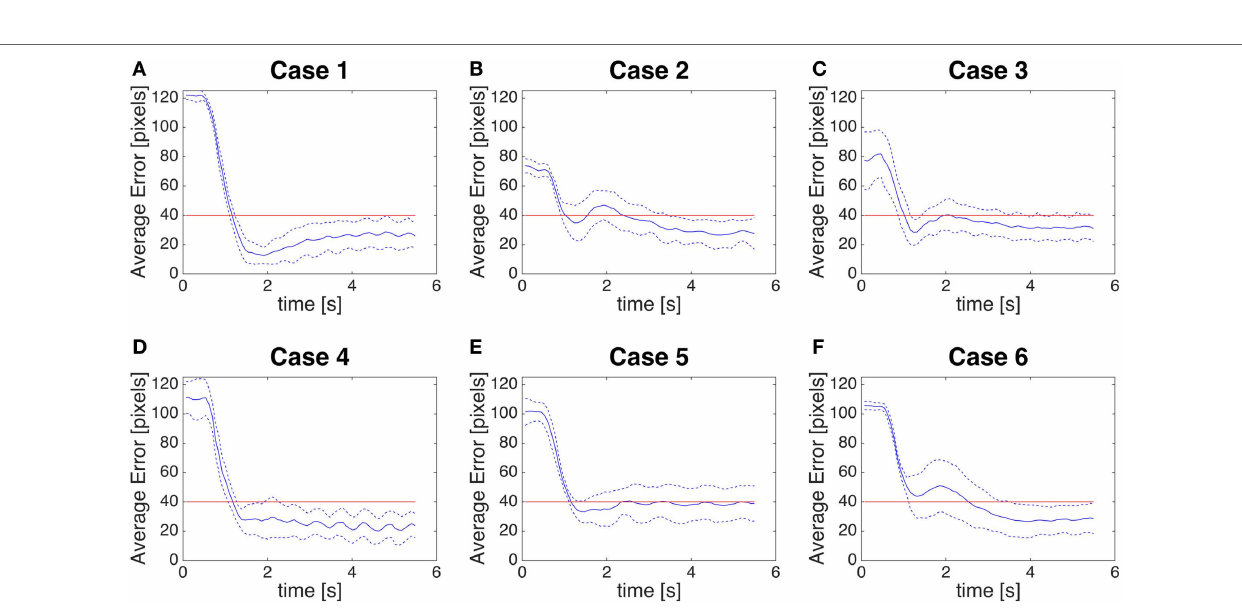
visible tool moved by a hidden agent. The proposed model could be exploited in industrial applications, for instance, in assembly lines tasks, with the aim of distinguishing between the movement of a human operator and an object moved by the conveyor belt.